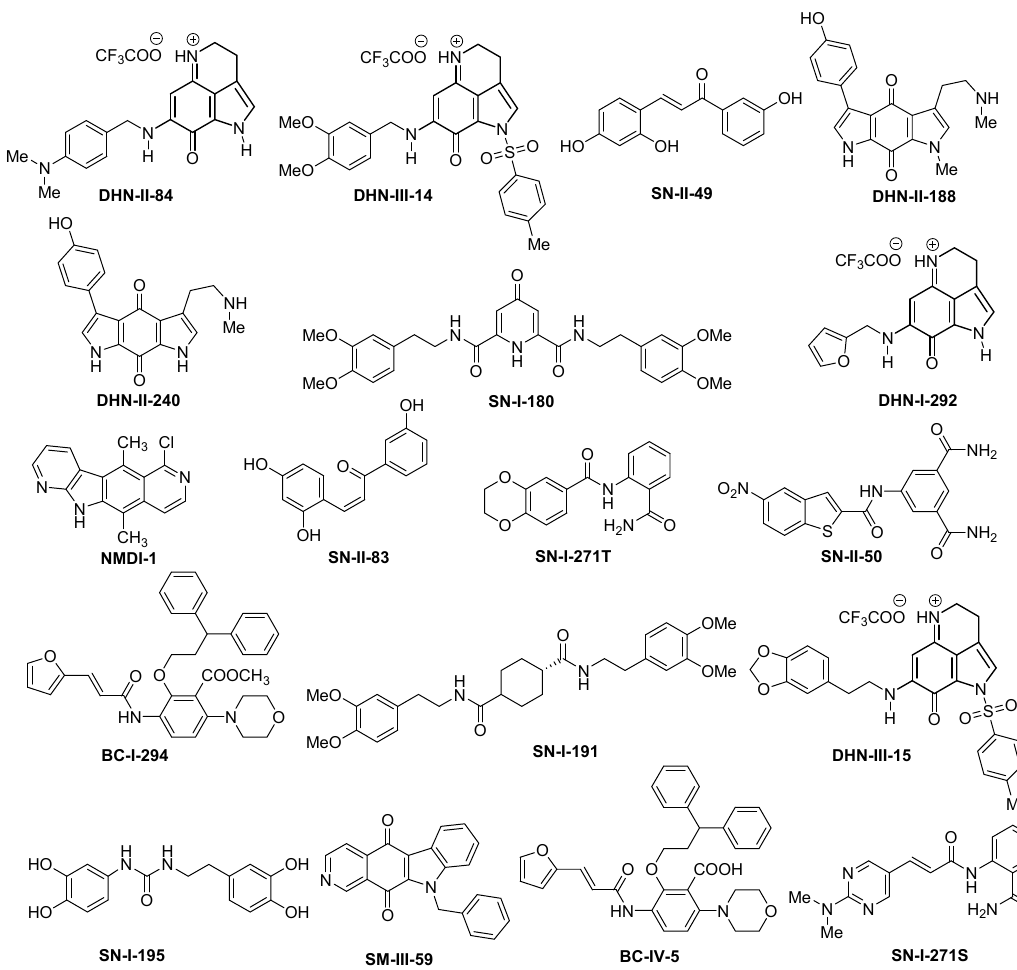
Figure 2. Chemical structures of 18 compounds used in the preliminary screening against pulmonary (H727) and thyroid (MZ-CRC-1 and TT) neuroendocrine tumor cell lines. MTT assays were used to determine the cytotoxic activity of these test compounds on neuroendocrine cancer cell proliferation. Pulmonary carcinoid cell lines (H727) and medullary thyroid cancer cell lines (MZ-CRC-1 and TT) were treated with increasing doses of the compounds up to 100 μ M concentration. The results of the screening are shown in Figure 3 and Table 1. Eight compounds (BC-IV-5, BC-I-294, NMDI-1, SN-I-271T, SN-I-180, SN-I-191, SN-I-195, SN-I-271S) failed to decrease the cell viability by >20% after 48 h of treatment. Six compounds (DNH-II-240, DHN-II-188, SN-II-50, SN-II-83, SN-II-49, DHN-I-292) decreased cell viability by >20%, but failed to inhibit 50% of the cell growth in all three cell lines. Only four compounds (DHN-II-84, DHN-III-14, DHN-III-15 and SM-III-59) decreased the cell viability by more than 50% at 50 μ M concentrations in all three cell lines. Based on their potency of inhibiting cell growth, the two makaluvamine analogs DHN-II-84 and DHN-III-14 were selected as lead compounds to be explored further. The IC 50 values of these compounds determined by MTT cell cytotoxicity assay were confirmed by CellTiter-Glo cell cytotoxicity assay (Figure 4). The MTT cell proliferation assay performed over six days showed that NET cell growth was inhibited in a dose-dependent manner, and the IC 50 values ranged from 0.1 μ M to 4 μ M (Figure 5). The IC 50 values for non-cancerous fibroblasts (WI-38 and 917) ranged from 1.5 μ M–5.8 μ M. (Figure S1), indicating several fold selectivity towards NET cells.